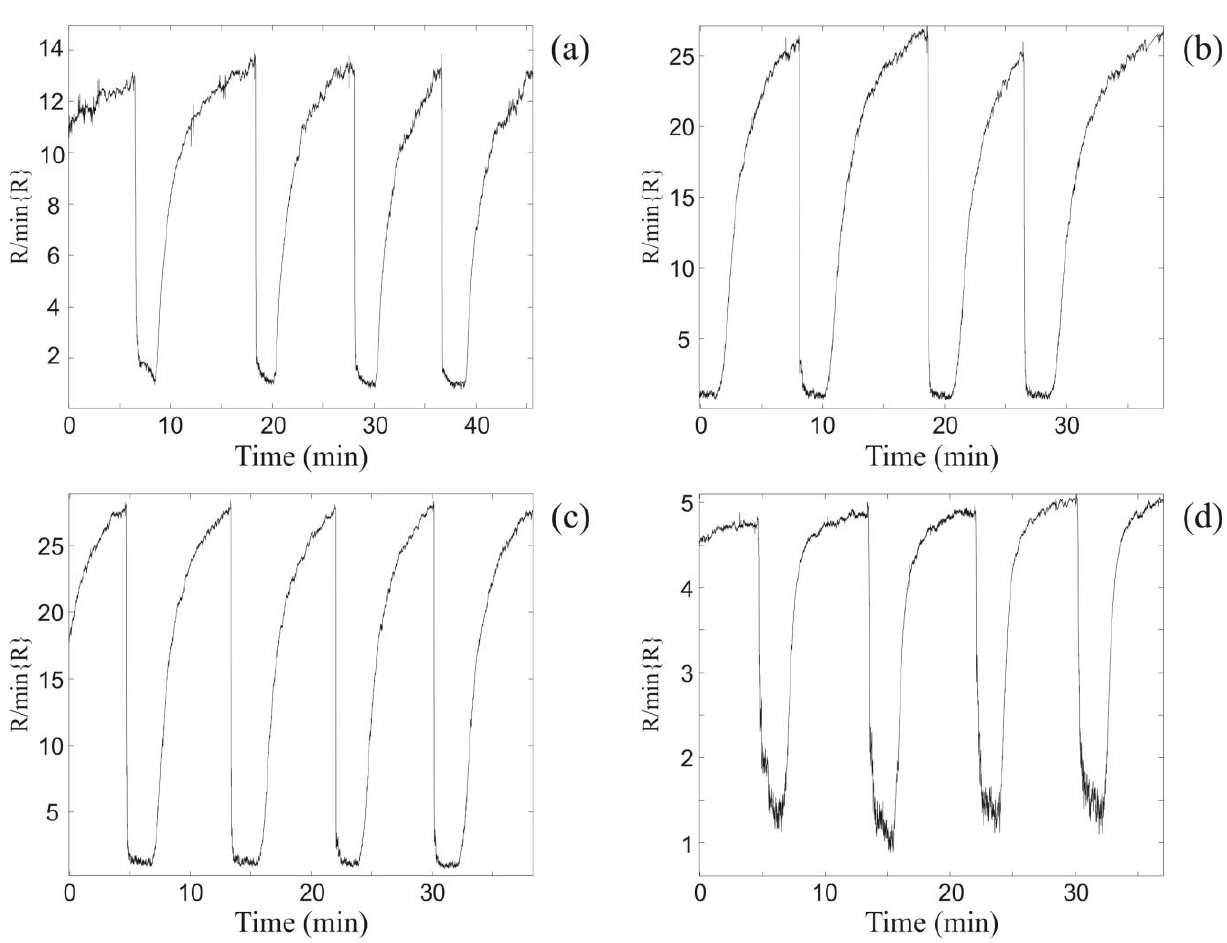
Figure 4. The relative changes in resistance of the xenon light bulb ZnO nanospring sensor upon exposure to 1,000 ppm consequent toluene pulses at different vapor gas mixture temperatures T and the optimal light bulb temperature T V